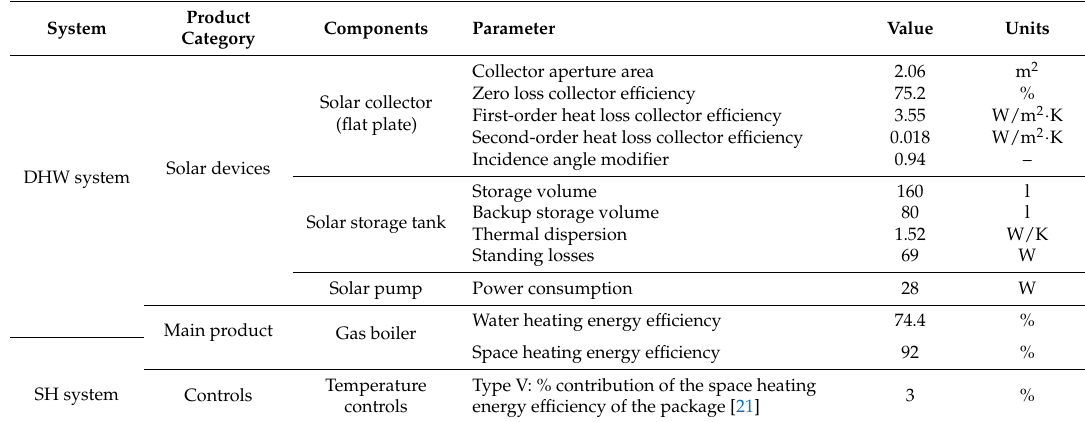
Table 4. Technical parameters of the heating systems in the case study.